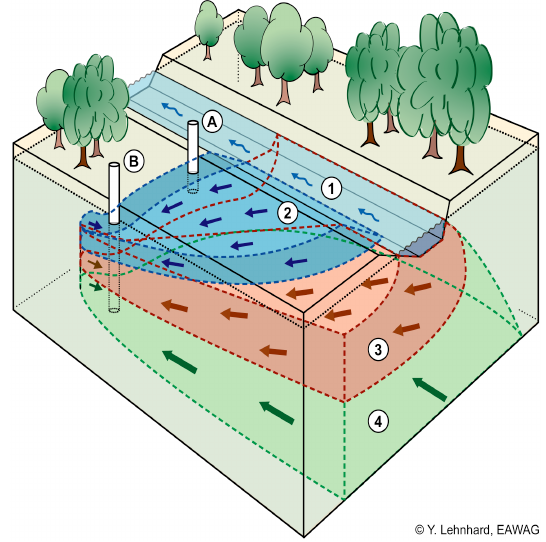
Fig. 4. Schematic block diagram showing relationship between a river, losing water through a saturated bed, and groundwater: (1) River (light blue), (2, 3) Groundwater of river-bank filtration origin (dark blue, < 300m flow distance from river, and < 20d resi- dence time; pink, > 300m flow distance from river, and > 20d resi- dence time), (4) groundwater not of bank-filtration origin